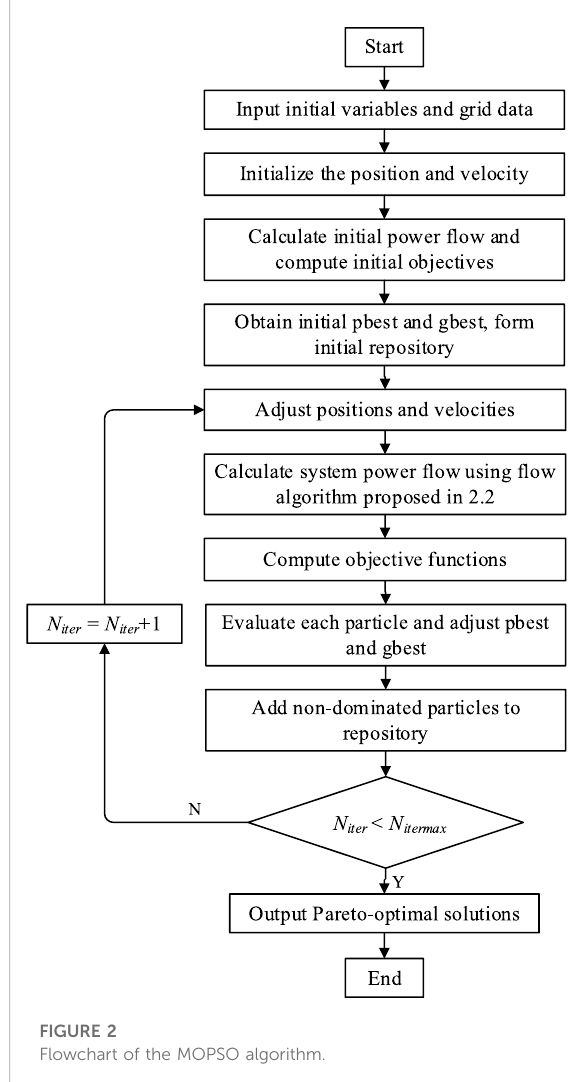
FIGURE 2 Flowchart of the MOPSO